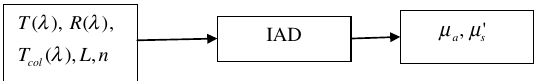
Fig. 3. IAD algorithm for retrival optical